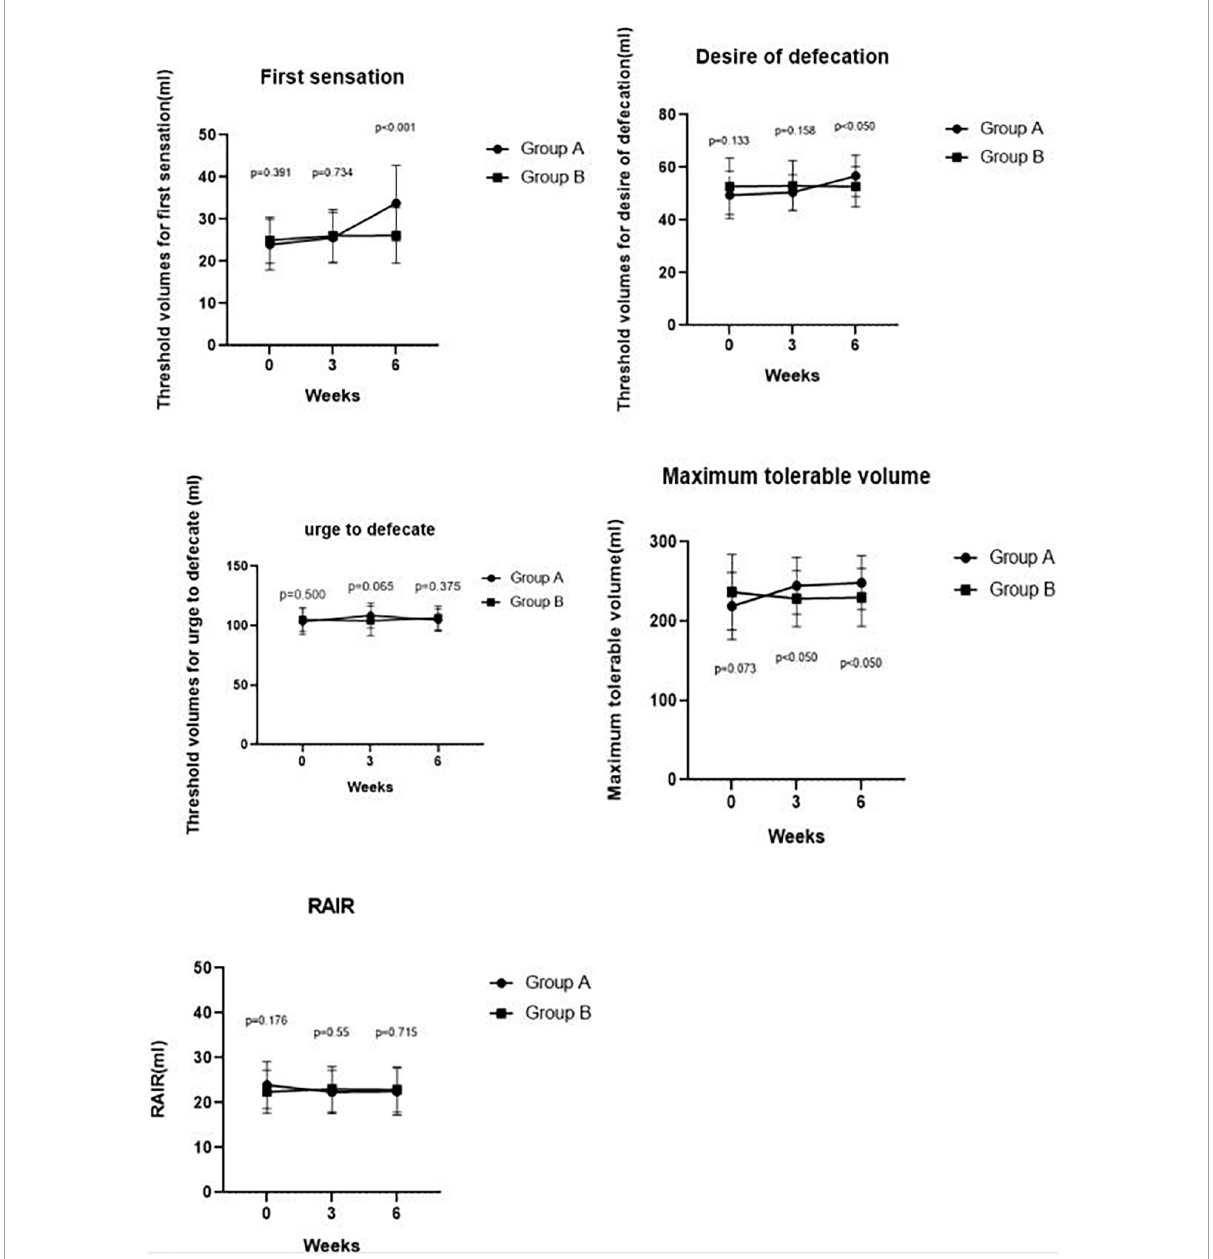
FIGURE3 Comparing RAIR, threshold volumes for the first sensation, the desire to defecate, urge to defecate and maximum tolerable volume pre-treatment and post-treatment at weeks 3, 6 between Groups A and B. We found a significant difference in the maximum tolerable volume between Groups A and B at week 3 ( p < 0.050). We also found significant differences in the first sensation, desire to defecate, and maximum tolerable volume between Groups A and Group B at week 6 ( p < 0.001, p < 0.050, and p < 0.050,